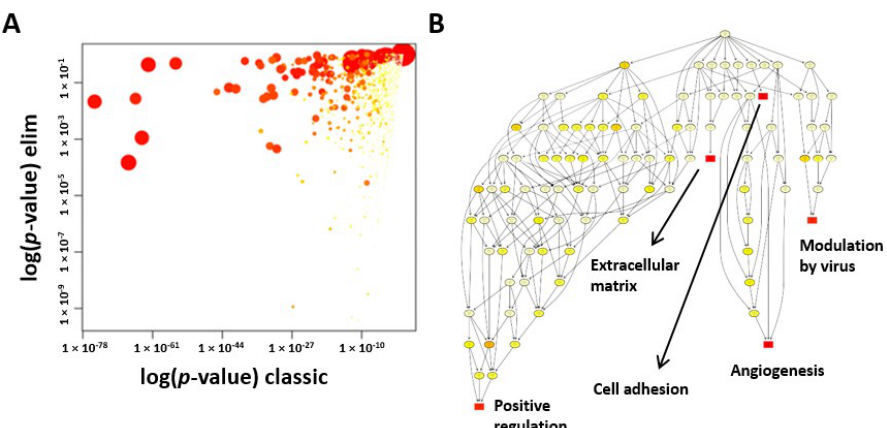
Figure 3. Gene Ontology (GO) analysis of ASCs and CSCs. ( A ) Scatter plot of the significantly enriched GO terms associated with genes that were differentially expressed between the ASCs and CSCs. The plot shows a comparison of the results obtained by the two statistical tests used. Values along diagonal were consistent between both methods. Values in the bottom left of the plot correspond to the terms with the most reliable estimates from both methods. The size of a dot is proportional to the number of genes mapping to that GO term, and the color represents the number of significantly differentially expressed transcripts corresponding to that term, with dark red representing more terms and yellow representing fewer. ( B ) The GO network generated for the enriched GO terms (biological process) associated with genes that were differentially expressed between the ASCs and CSCs. The nodes are colored from red to yellow, with the node with the strongest support colored red and nodes with no significant enrichments colored yellow. The five nodes with the strongest support are marked with rectangular